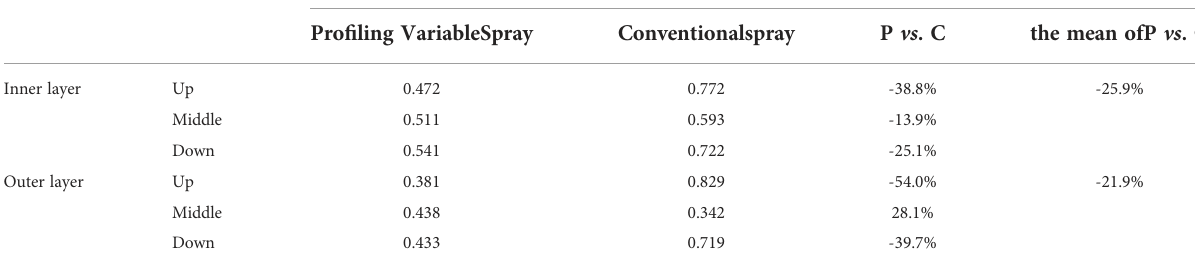
TABLE 2 spray coef fi cient of variation